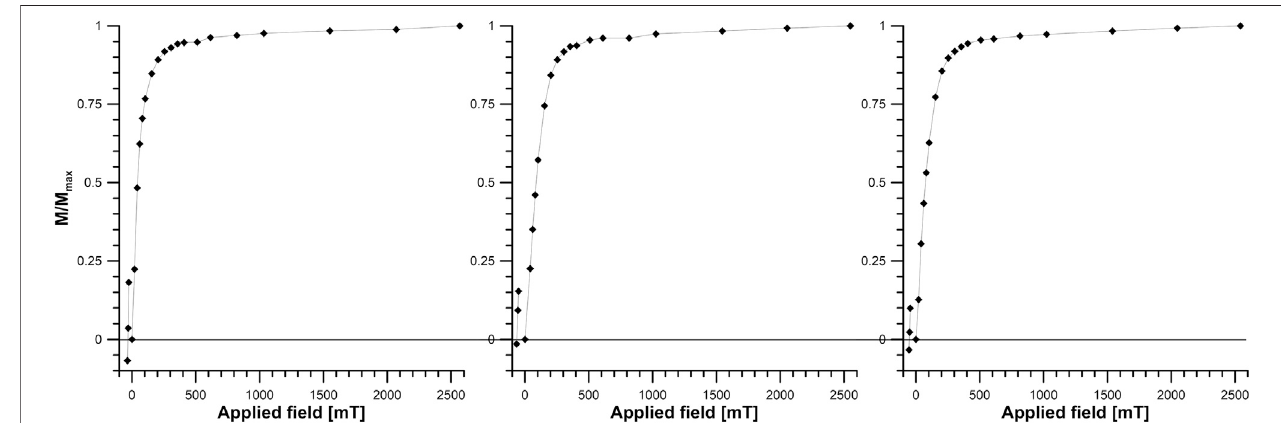
FIGURE7| Acquisitionandback- fi eldcurvesoftheIsothermanRemanentMagnetisation(IRM)forthreesamples.Theordinatedenotesthemagnetisationoverthe maximal magnetisation at the highest applied fi eld. Note that magnetisation increases steeply with the applied fi eld until ∼ 300 mT, and increases slowly thereafter. The fi eld necessary to reduce the net remanence to zero lies between 32 and 64